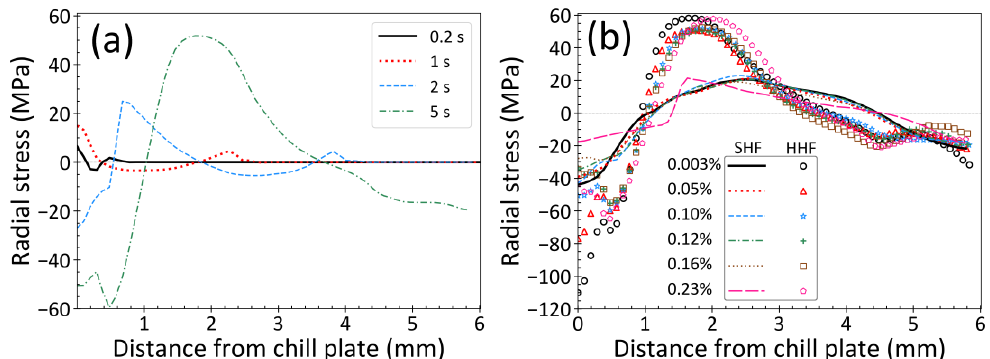
Figure 6. Radial stress profiles through the droplet height calculated at centerline symmetry axis. ( a ) Evolution with time for 0.10%C steel with HHF, and ( b ) Final profiles for six examined steels and different heat fluxes.